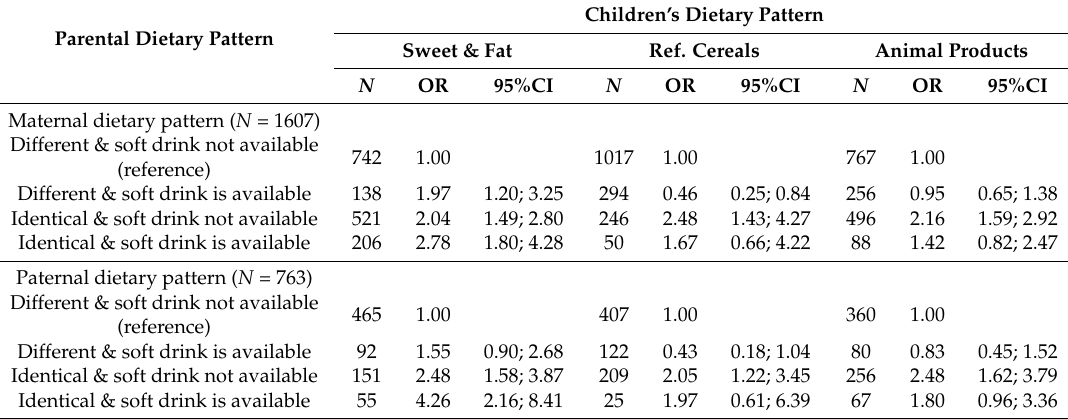
Table 5. Odds Ratios (OR) and confidence intervals (CI) for a child being allocated to a dietary pattern depending on parental dietary pattern and availability of soft drinks during meals, given by sex of parents; all models were adjusted for age and BMI z -score of child, parental BMI, highest ISCED of family, and country of